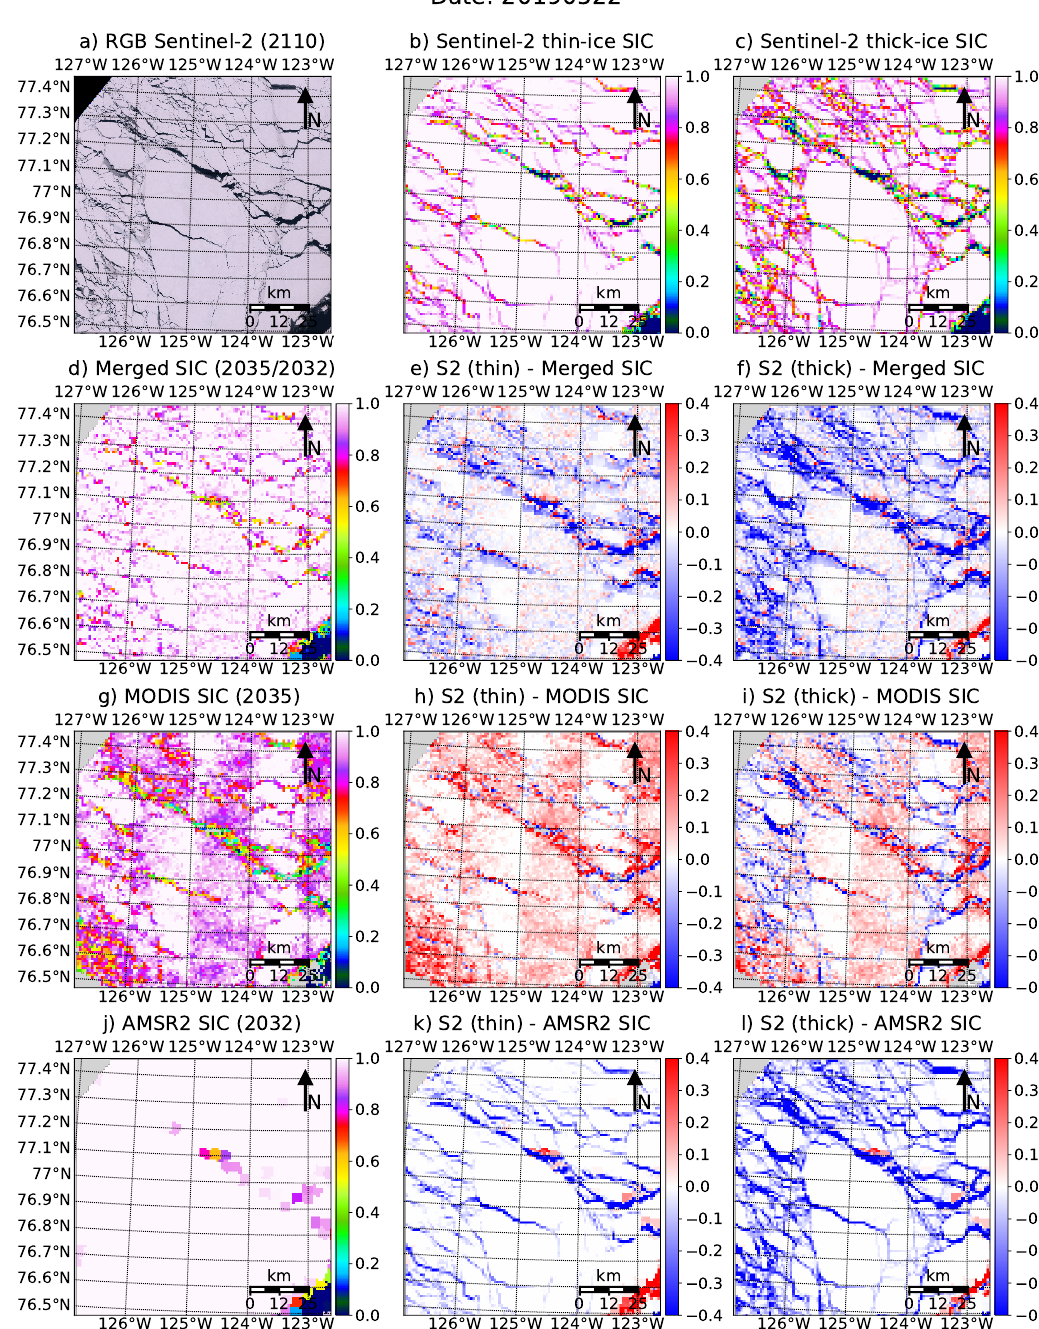
Figure 11. Sentinel-2 scene in the Beaufort Sea on 22 May 2019 and the corresponding SIC maps. ( a ) Sentinel-2 RGB image. Sentinel-2 SIC with thin ice considered as ice ( b ) and water ( c ). ( d – f ) The merged SIC and their difference to the thin- and thick ice Sentinel-2 SIC. Panels ( g – l ) show the same for the MODIS and AMSR2 SIC, respectively. The acquisition times for the single scenes in UTC are given in brackets in the titles of the maps in the left